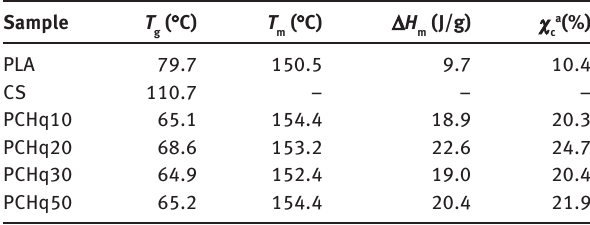
Table 1: Wavenumbers of characteristic groups in Fourier transform infrared spectra of hydroquinine (Hq), and PLA/CS/hydroquinine (PCHq) nanoparticles.